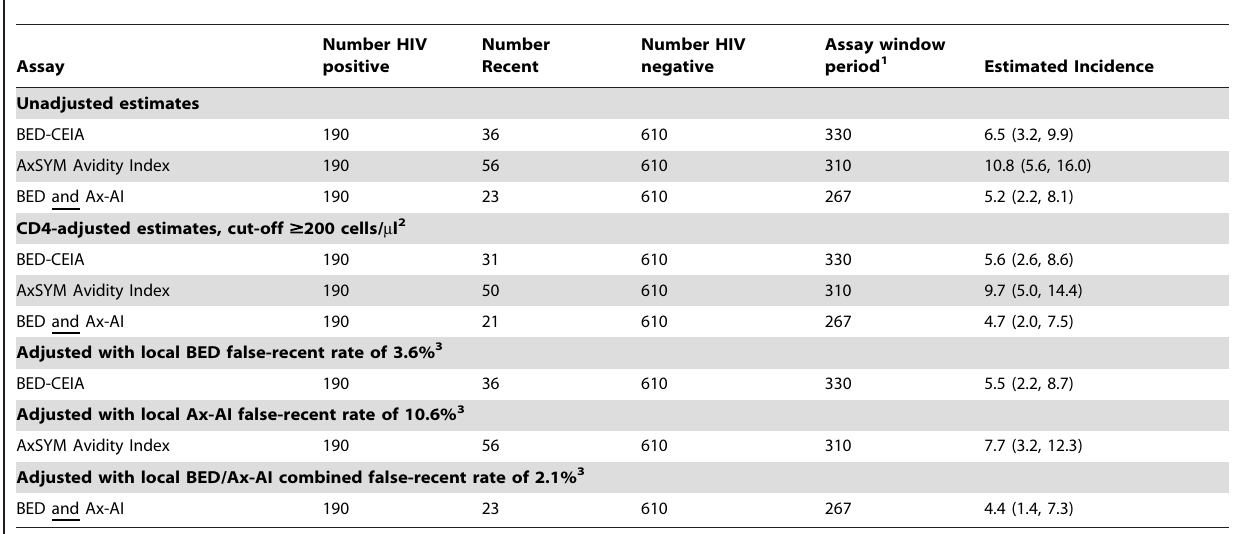
Table 2. HIV incidence estimates based on STARHS assays among ARV-naı¨ve, high-risk women in Kigali, Rwanda.